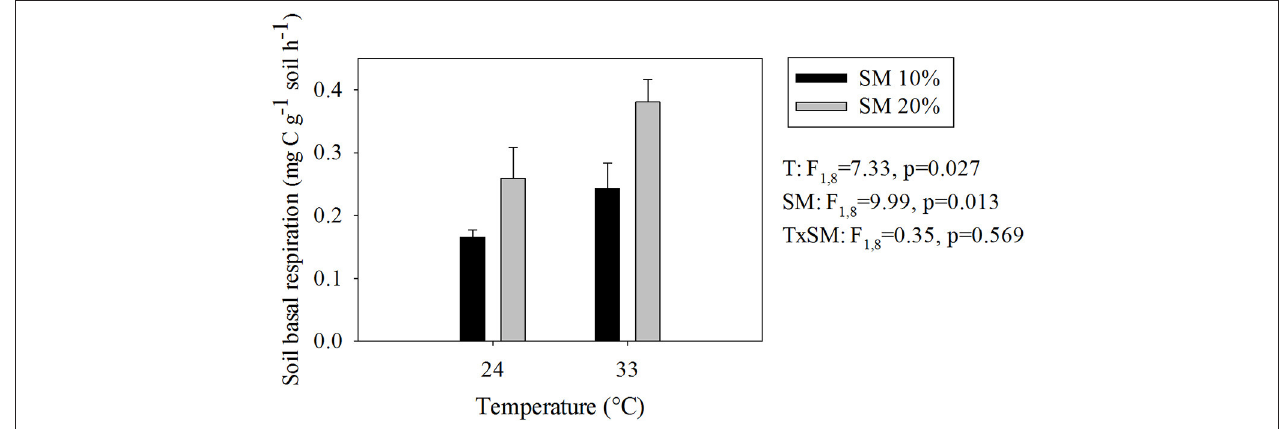
FIGURE 1 | Soil basal respiration rates at different temperature and soil moisture conditions. Values represent means ± SE. SM, Soil